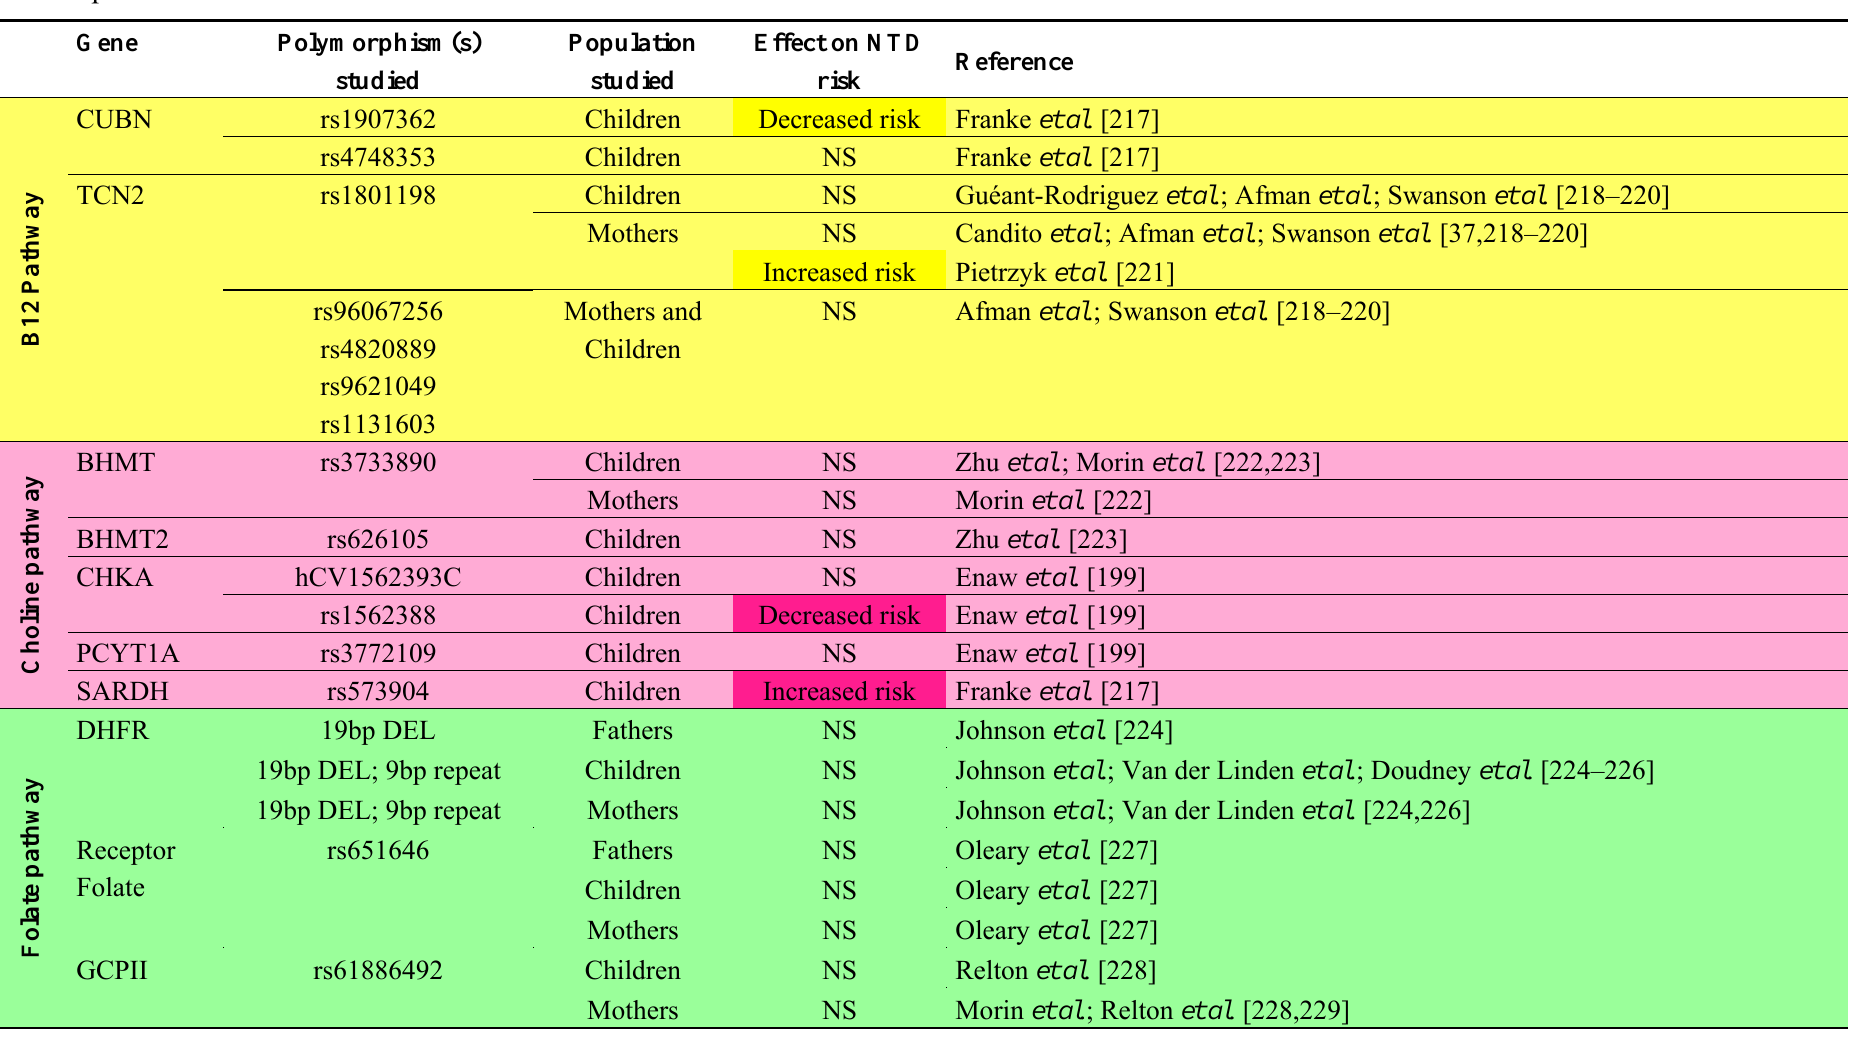
Table 2. Polymorphisms from genes involved in folate, choline, B12 vitamin pathway and remethylation cycle that have been studied for their implication in NTDs